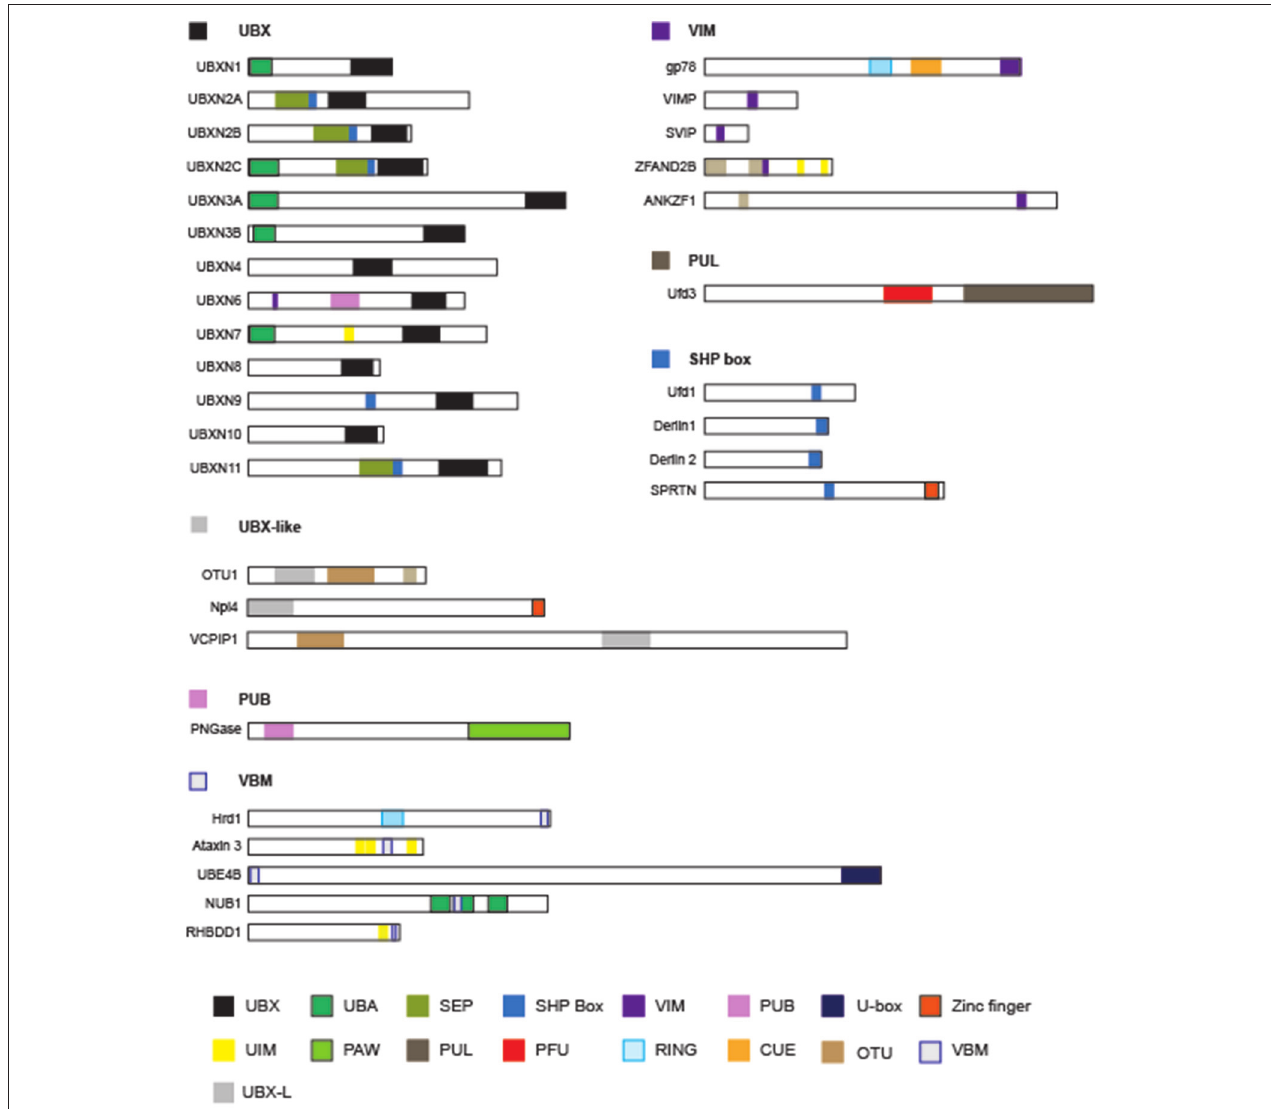
FIGURE 3 | The domain structures of p97-interacting proteins. Known p97-interacting proteins are grouped by their p97-interacting domains, which are highlighted by colored boxes: UBX, ubiquitin like/ubiquitin regulatory X; UBA, ubiquitin associated; SEP, Shp1, Eyc and p47; VIM, VCP interacting motif; PUB, Peptide:N-glycanase/UBA or UBX-containing proteins; UIM, ubiquitin interacting motif; PAW, domain present in PNGases and other worm proteins; PUL (PLAP, UFD3 and Lub1) domain; PFU, PLAA family ubiquitin binding; RING, really interesting new gene; CUE (Coupling of Ubiquitin to ER-degradation) domain; UIM, ubiquitin interacting motif. The schematic representations are drawn to